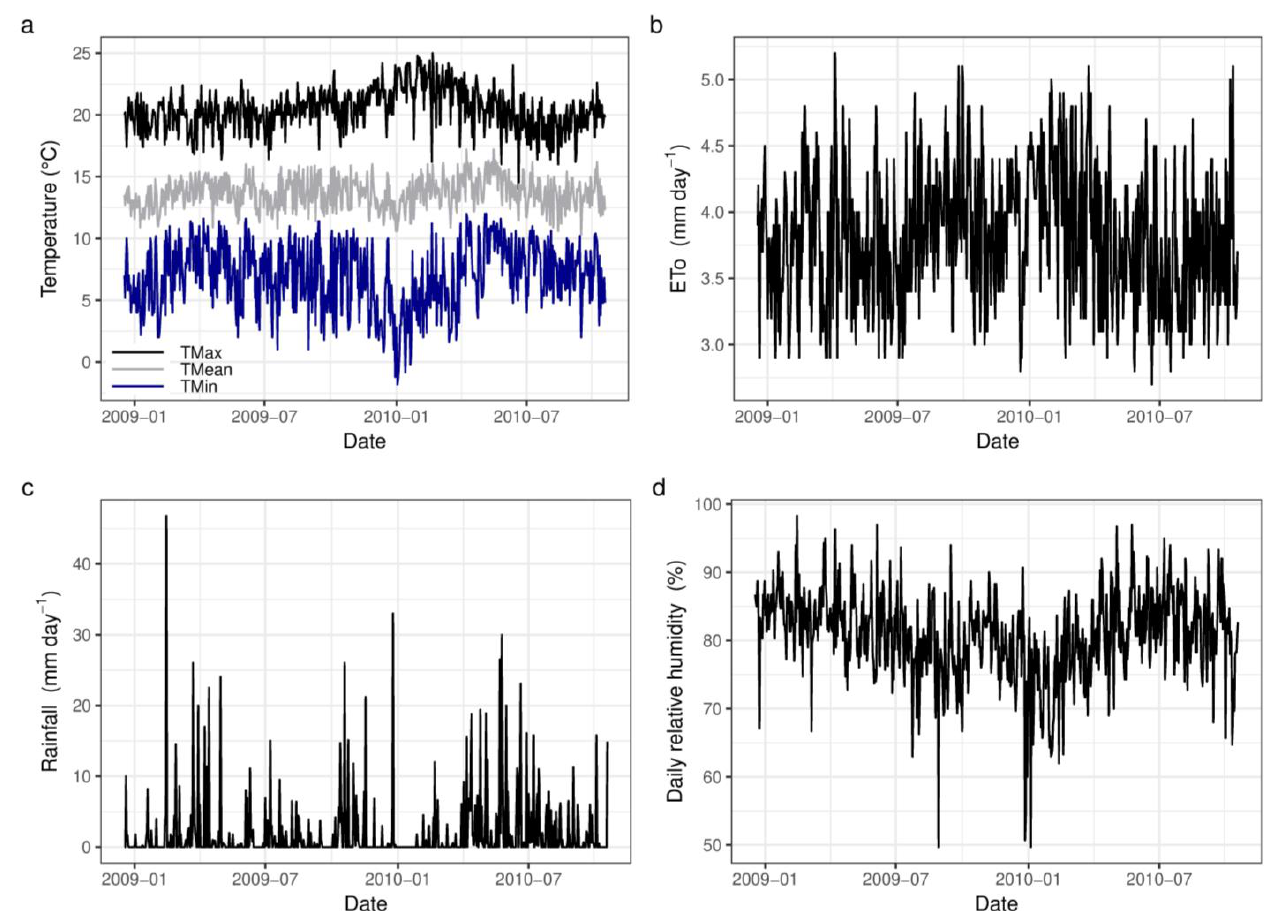
Figure 1. Daily weather data ( a ) maximum temperature (T max ), minimum temperature (T min ), mean temperature (T mean ); ( b ) reference evapotranspiration (ET 0 ); ( c ) rainfall; ( d ) relative humidity during the experiment period from December 2008 to October 2010 on the research site.